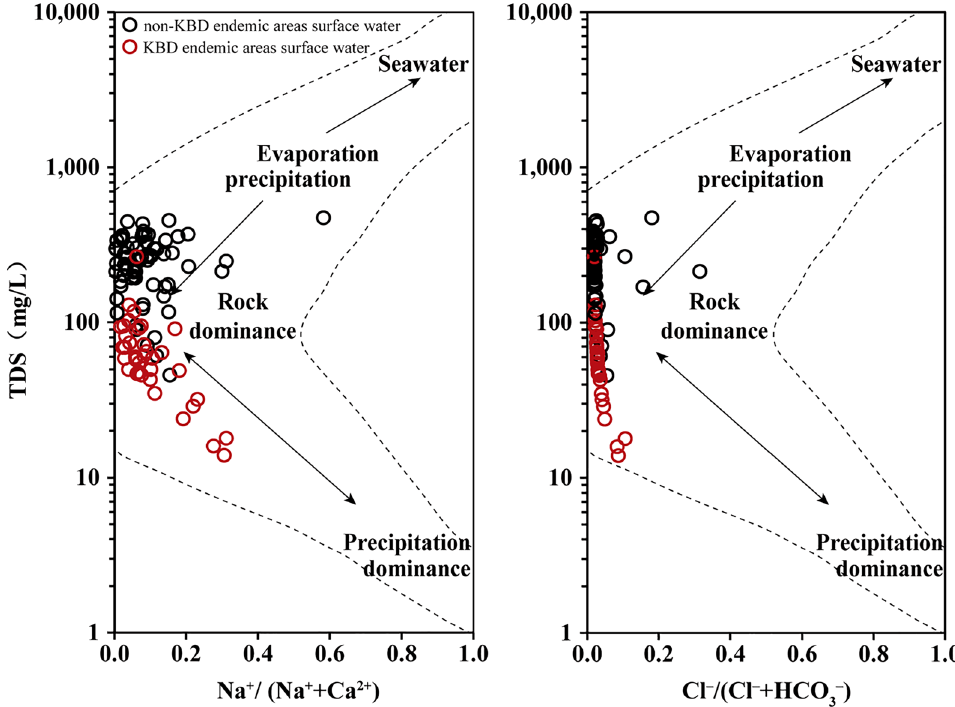
Figure 4. Gibbs boomerang envelope 7 plot showing possible sources of ions in surface waters in the Longzi